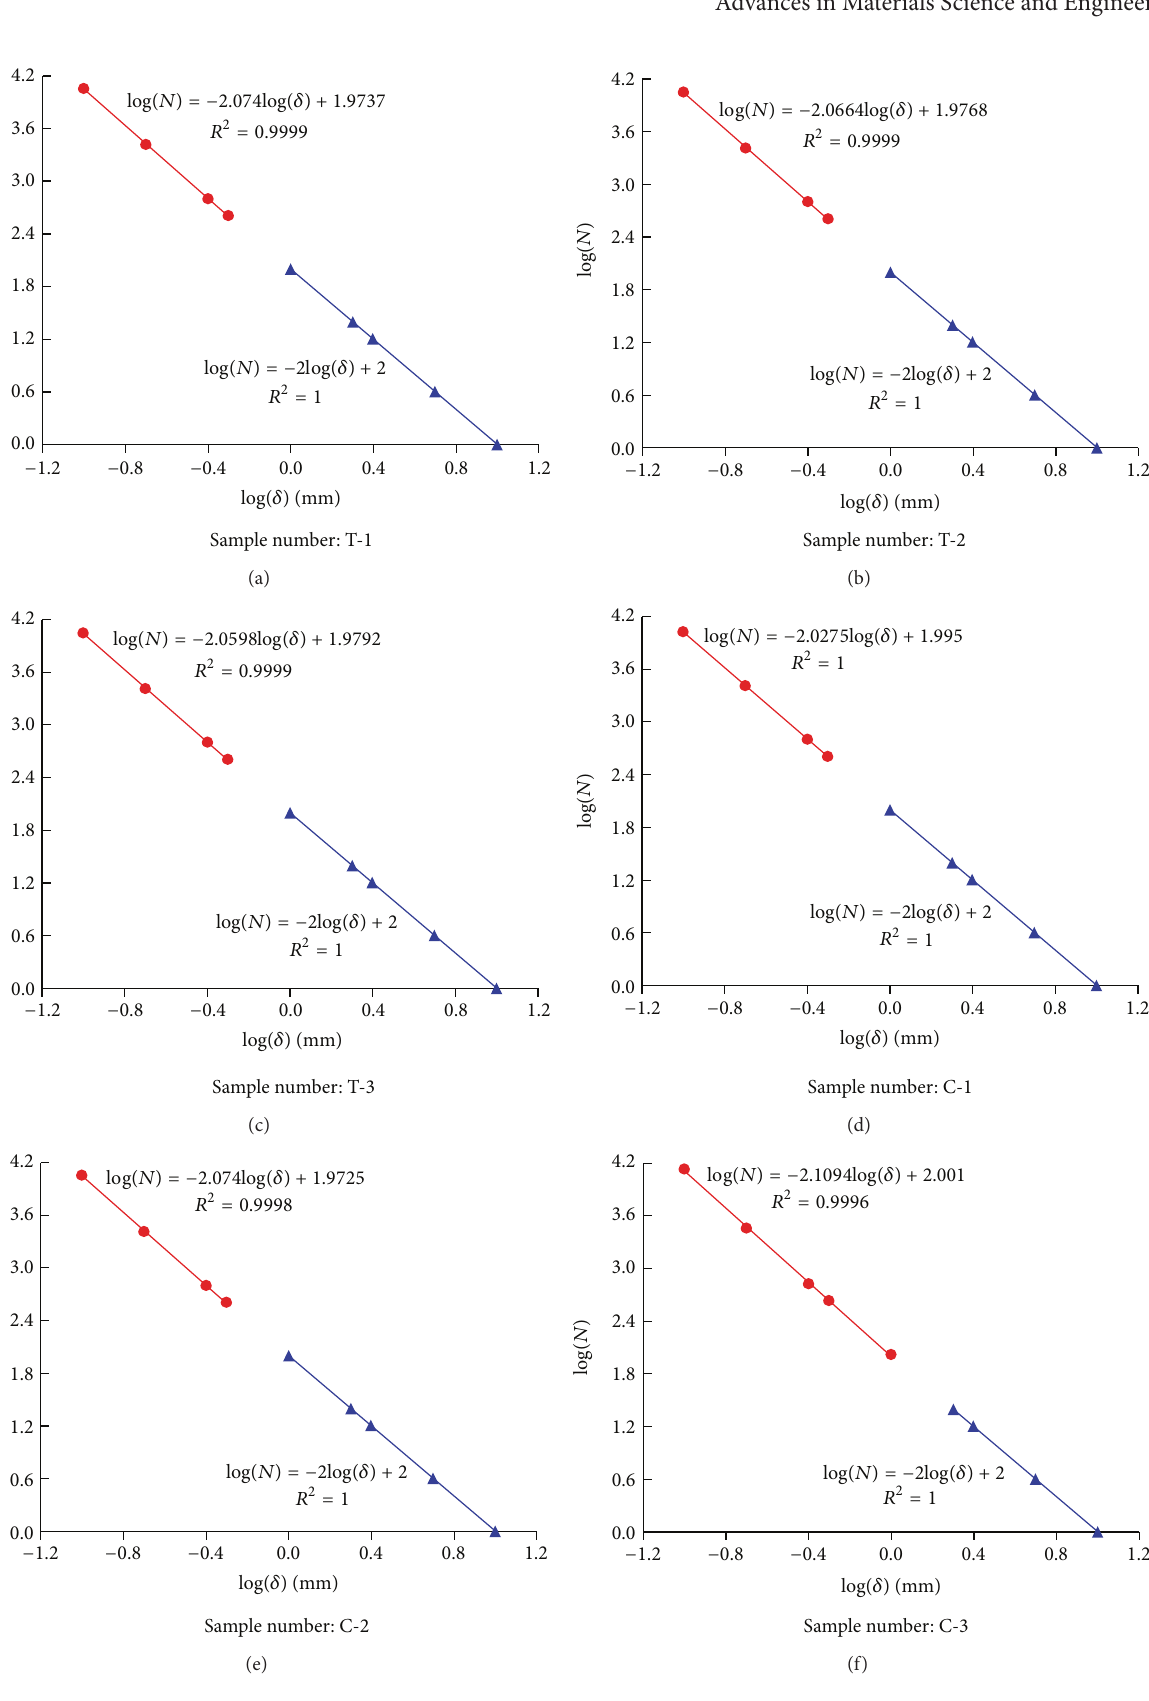
Figure 6: Log-log plots of N ( 𝛿 ) and 𝛿 for each fracture